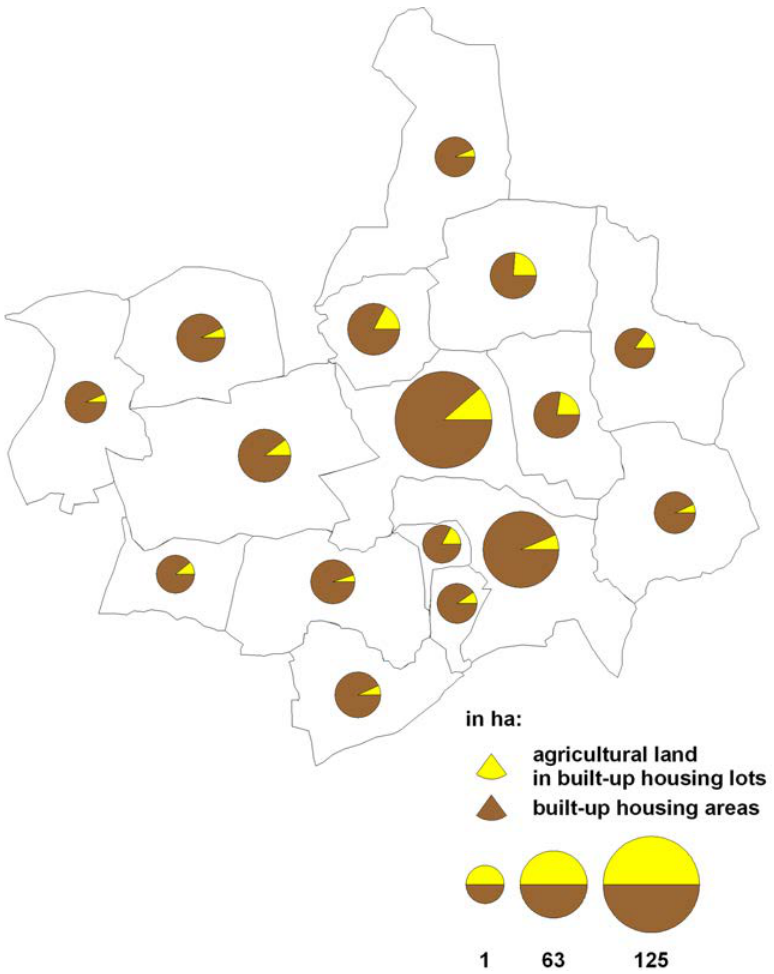
Fig. 6. Total housing area (all housing areas in the commune) and farmland on built-up housing lots in Rokietnica commune, 2014. Source: own compilation on the basis of data from the Poviat Centre of Geodetic and Cartographic Documentation in